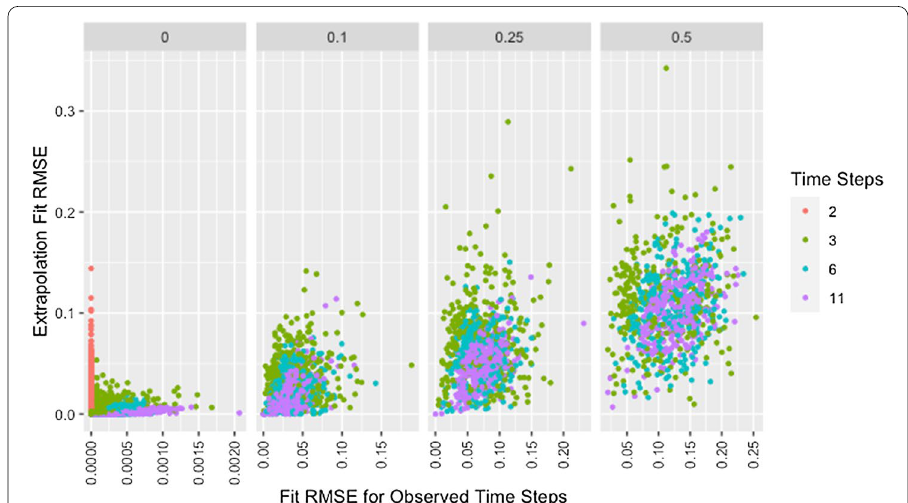
Fig. 13 Extrapolation RMSE by fit RMSE, time steps, and missingness. RMSE for observed and predicted opinions on extrapolated time steps by RMSE for observed and predicted opinions on observed time steps, number of time steps, and proportion of missing data across panels with different x-axis scales